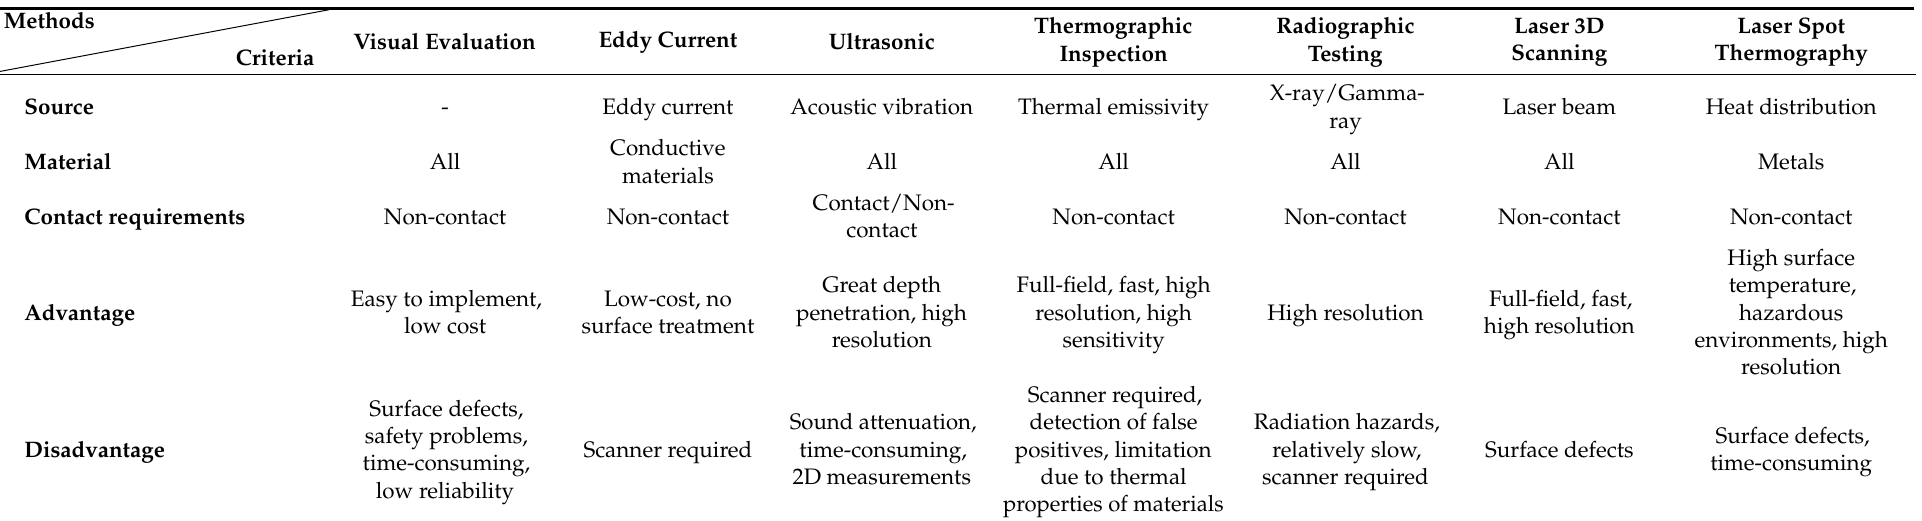
Table 1. An overview of the NDE methods and their advantages and